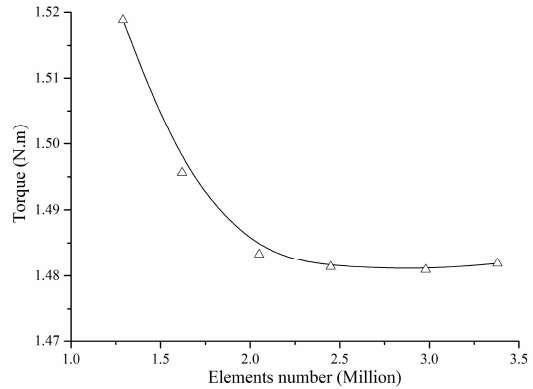
Figure 4. Reference variable (torque on the shaft) as function of the number of mesh